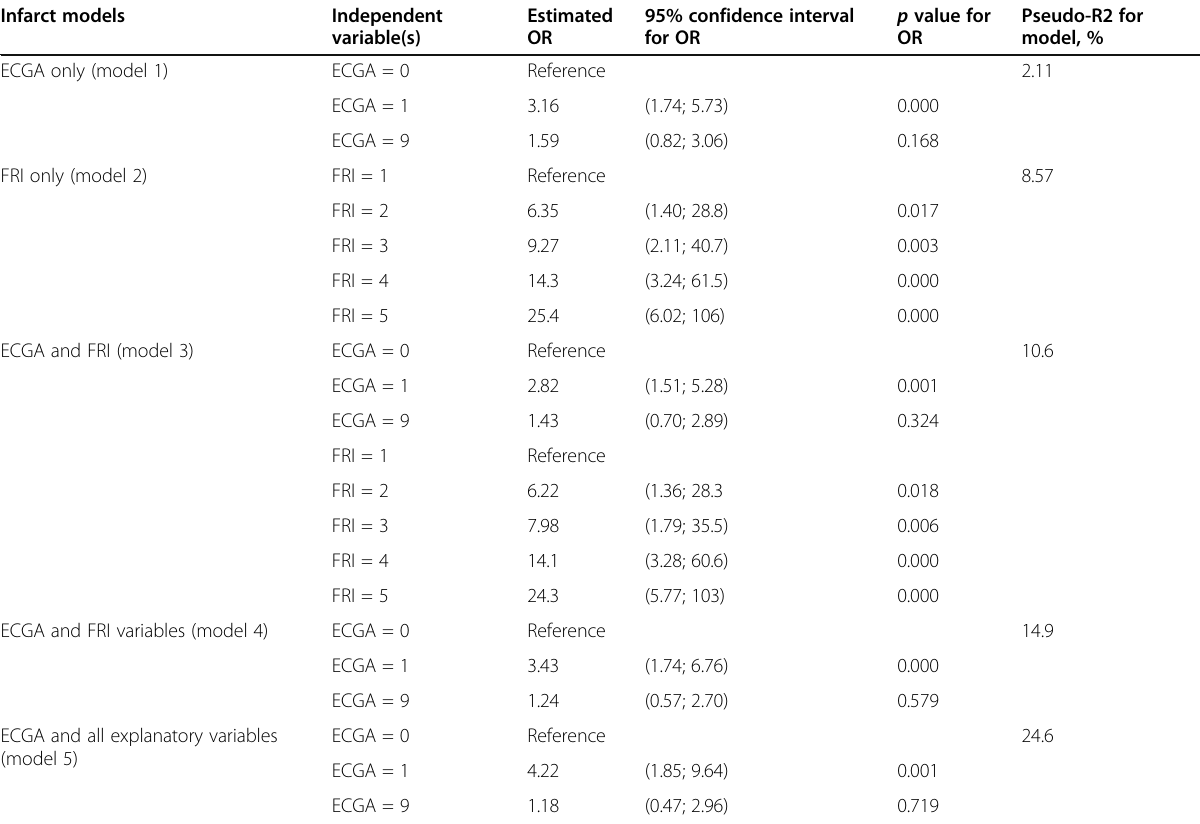
Table 7 Results for regression models with first MI as a dependent variable with ECGA and additional independent variables of the 977 cohort participants of men aged 45 – 50 at baseline in 1993 followed for 25 years Infarct